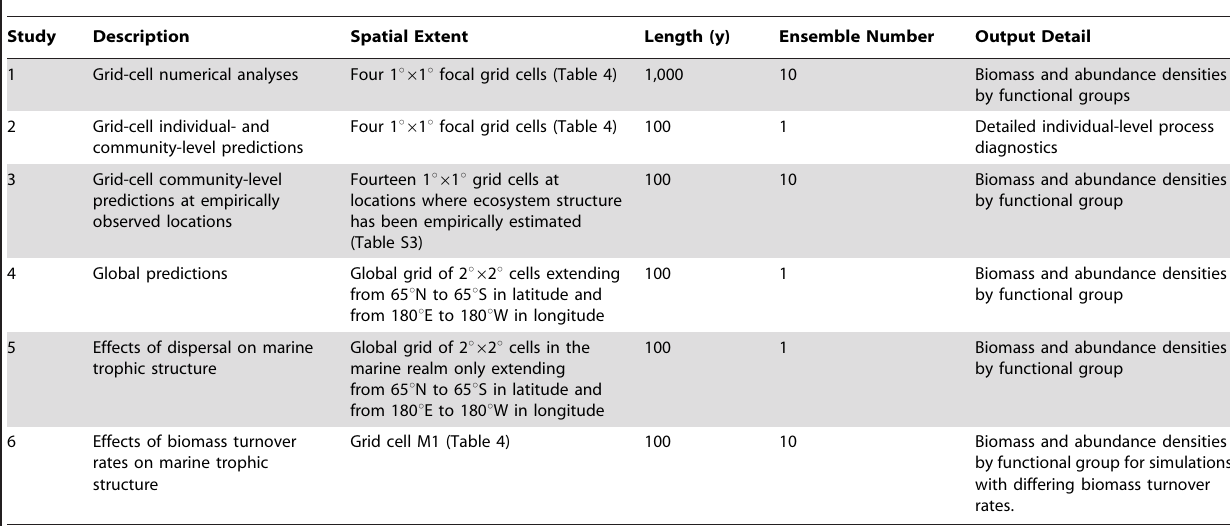
Table 3. Settings used for the six model studies conducted in this research article.